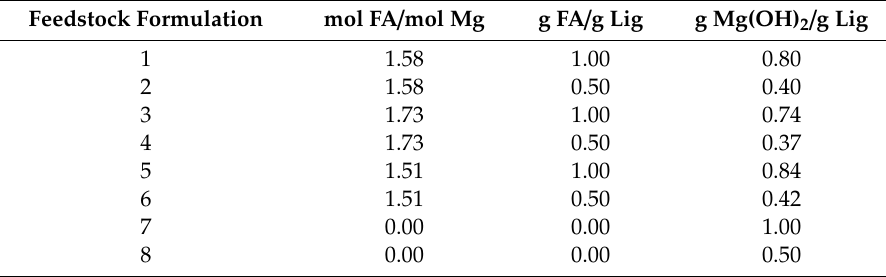
Table 2. Feedstock